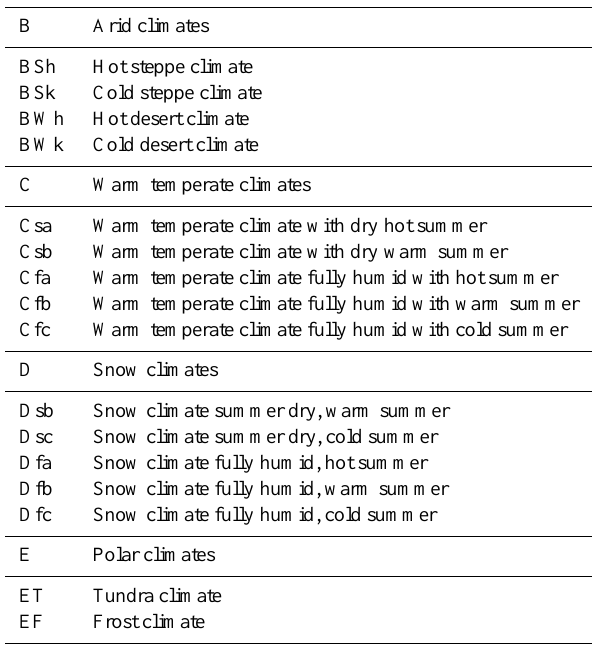
Table 4. Köppen–Geiger climate types used for model